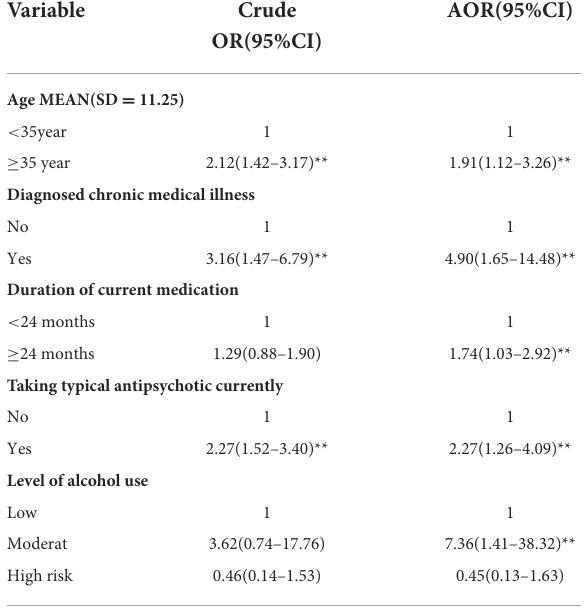
TABLE 3 Bivariate and multivariate analyses of factors associated with sexual dysfunction among respondents attending follow-up treatment at the Jimma University Medical Center Psychiatry Clinic, Jimma, southwest Ethiopia, 2022, ( N =